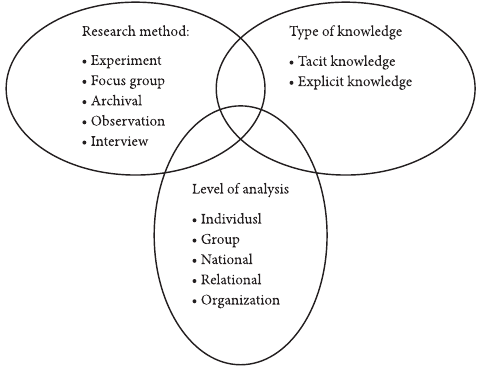
Figure 2. Research matrix suggested (source: authors,